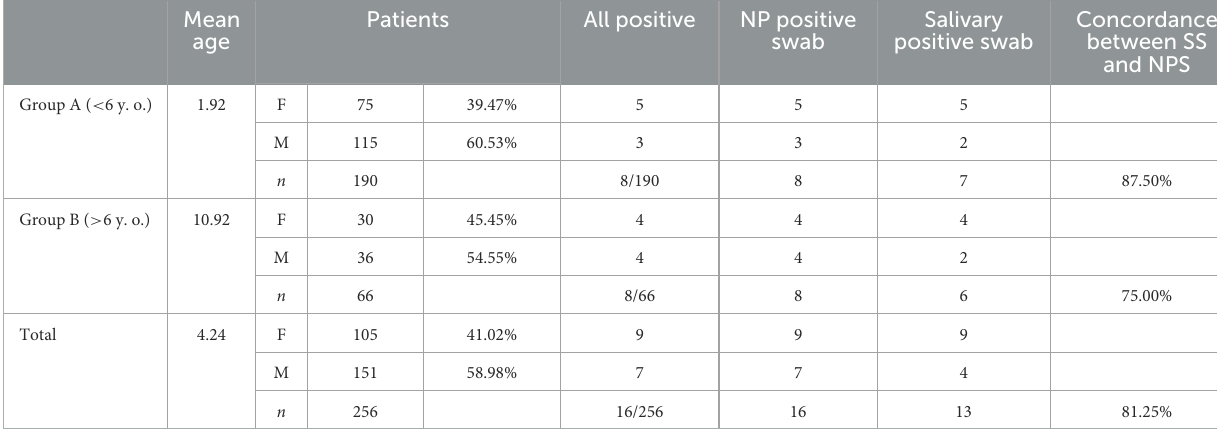
TABLE 2 Frequency of positive-paired NP and saliva swabs from all 256 patients enrolled in this study. Mean Patients All positive NP positive age Group A ( < 6 y. o.)